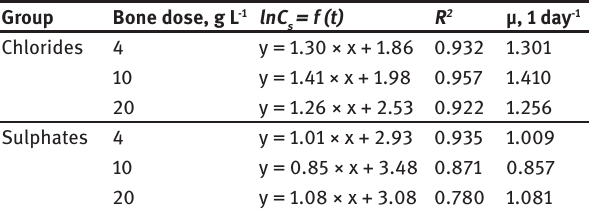
Figure 3: (A) The growth rate of Bacillus megaterium cells in two different medium composition (chlorides and sulfides) and three different doses of bones (4 g L -1 , 10 g L -1 , 20 g L -1 ); (B) The growth rate of P O concentration in relationship to the time in the solubilization 2 5 process. Table 4: The equation describing the specific growth rate of B. megaterium in two different medium compositions and three different doses of bones.